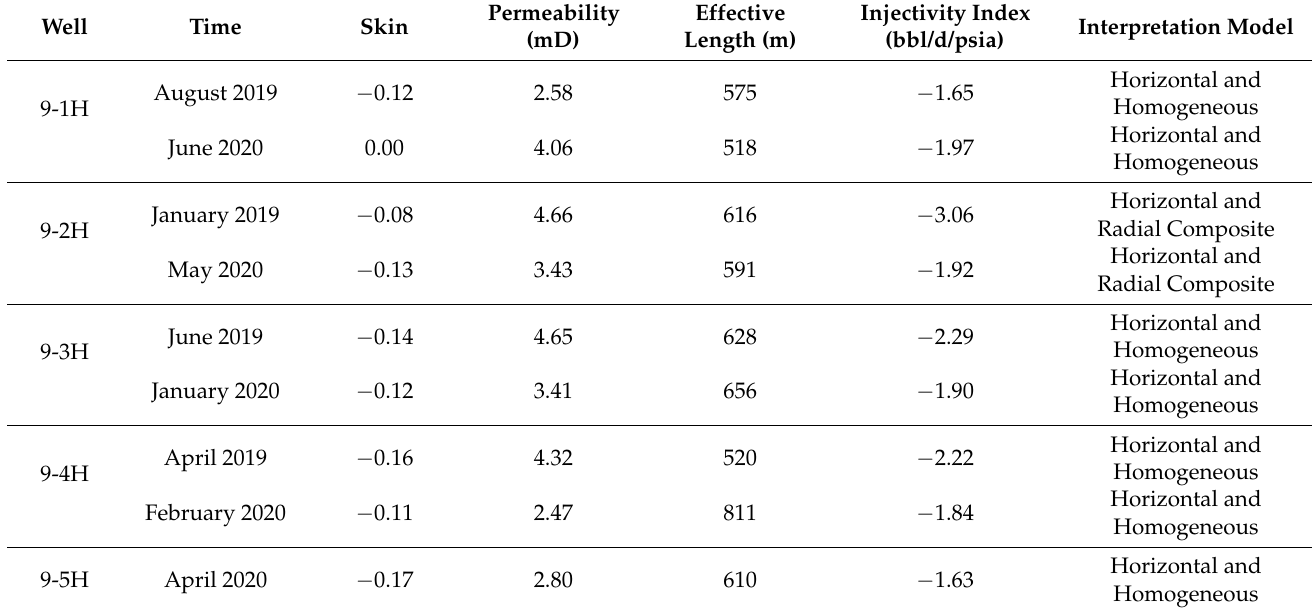
Table 3. Comparison table of well test parameters of injection wells.